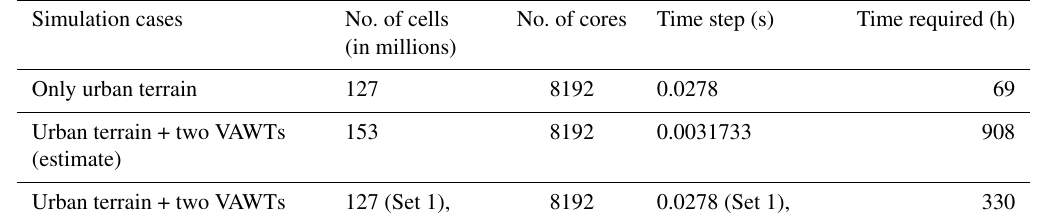
Table 2. Overview of computational cost of different cases.